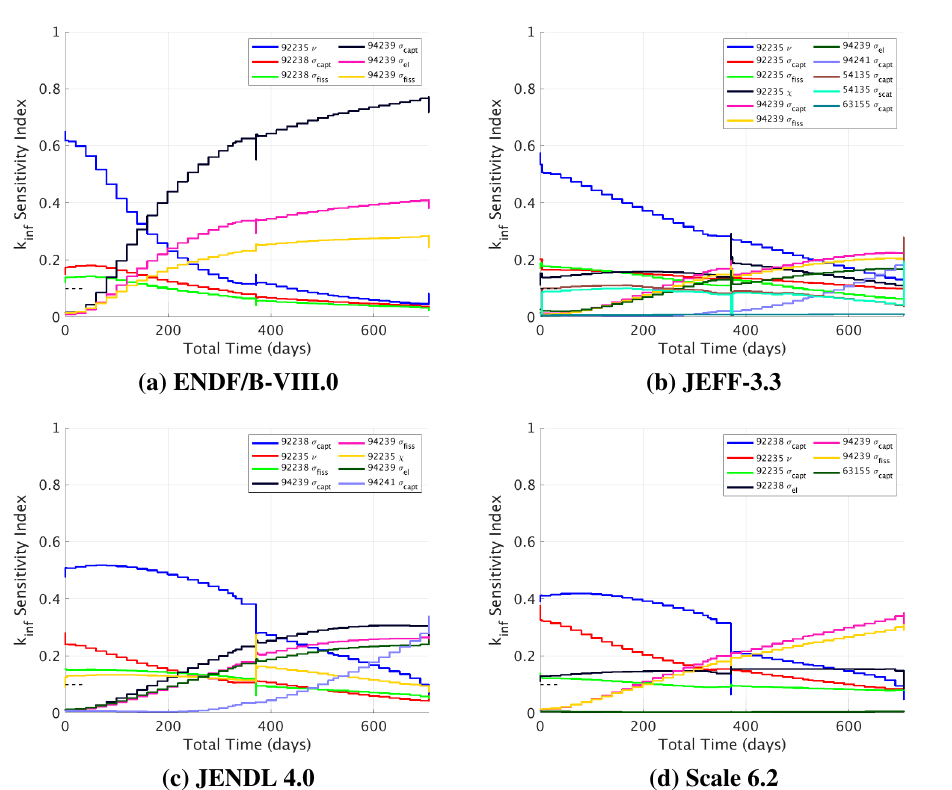
Figure 2: Evolution of the sensitivity indices for the 3 nuclides reaction pairs contributing the most to k uncertainty for various sources of inf